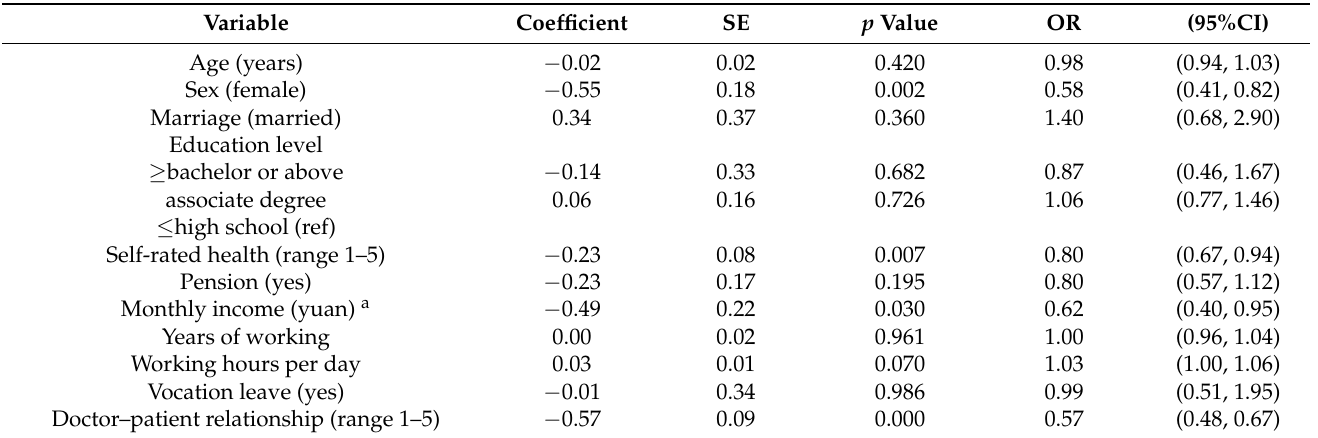
Table 3. Logistic regression analysis of influential factors with burnout of village